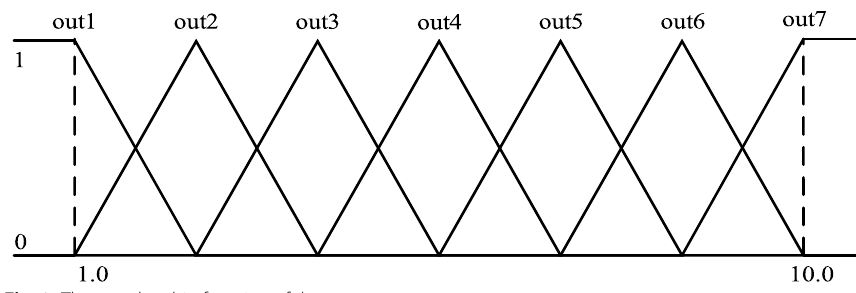
Fig. 9 The membership function of the